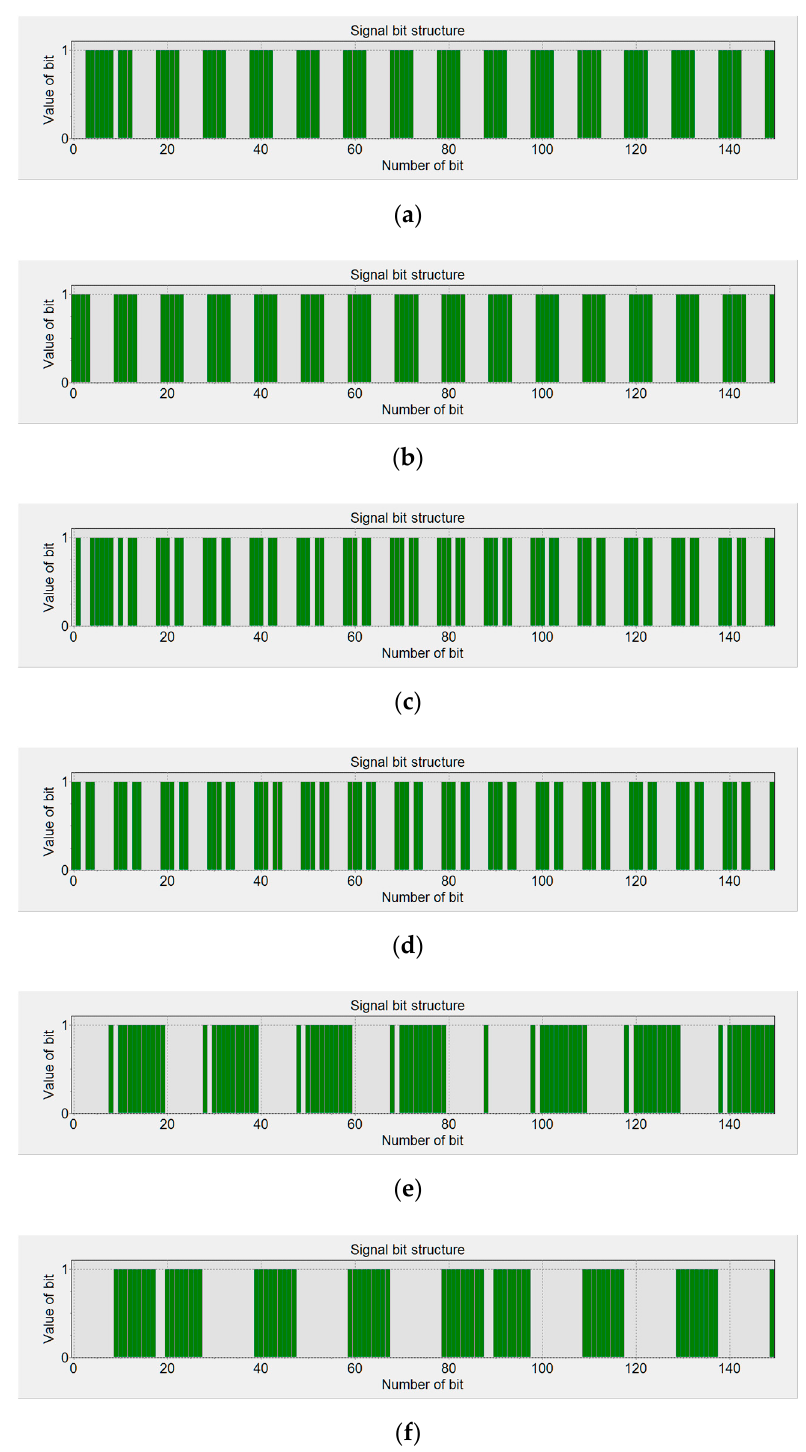
Figure 11. Sequences of bits for selected colors values after application of TMDS coding: ( a ) the value 8, ( b ) the value 238, ( c ) the value 22, ( d ) the value 210, ( e ) the value 0, and ( f ) the value 255. Calculations according to Equations (4) and (5) were performed for the above-listed background and font color pairs, obtaining specific bit strings. The analysis was performed using the images presented in Figure 4. The images were recovered by using raster scanning method [31] for a pre-set image width (known number of pixels). Their form corresponds to images that can be retrieved under perfect conditions for measurement of compromising emanations at the SCA output.